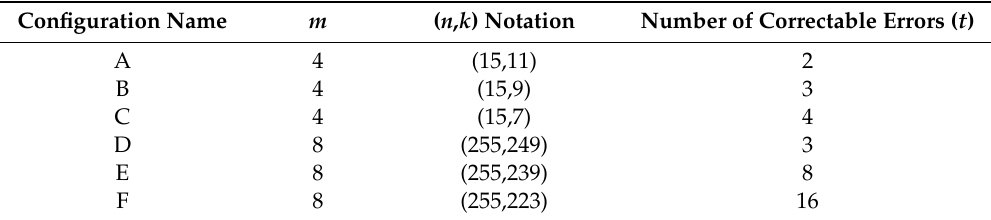
Table 3. Configurations designed for the implementation comparison.